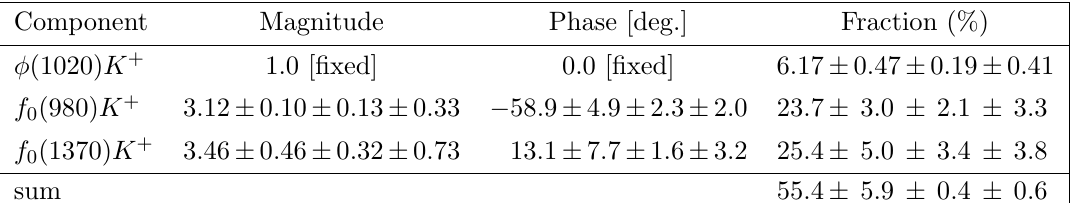
, (top right) s , (bottom left) K + K (cid:0) K + K +